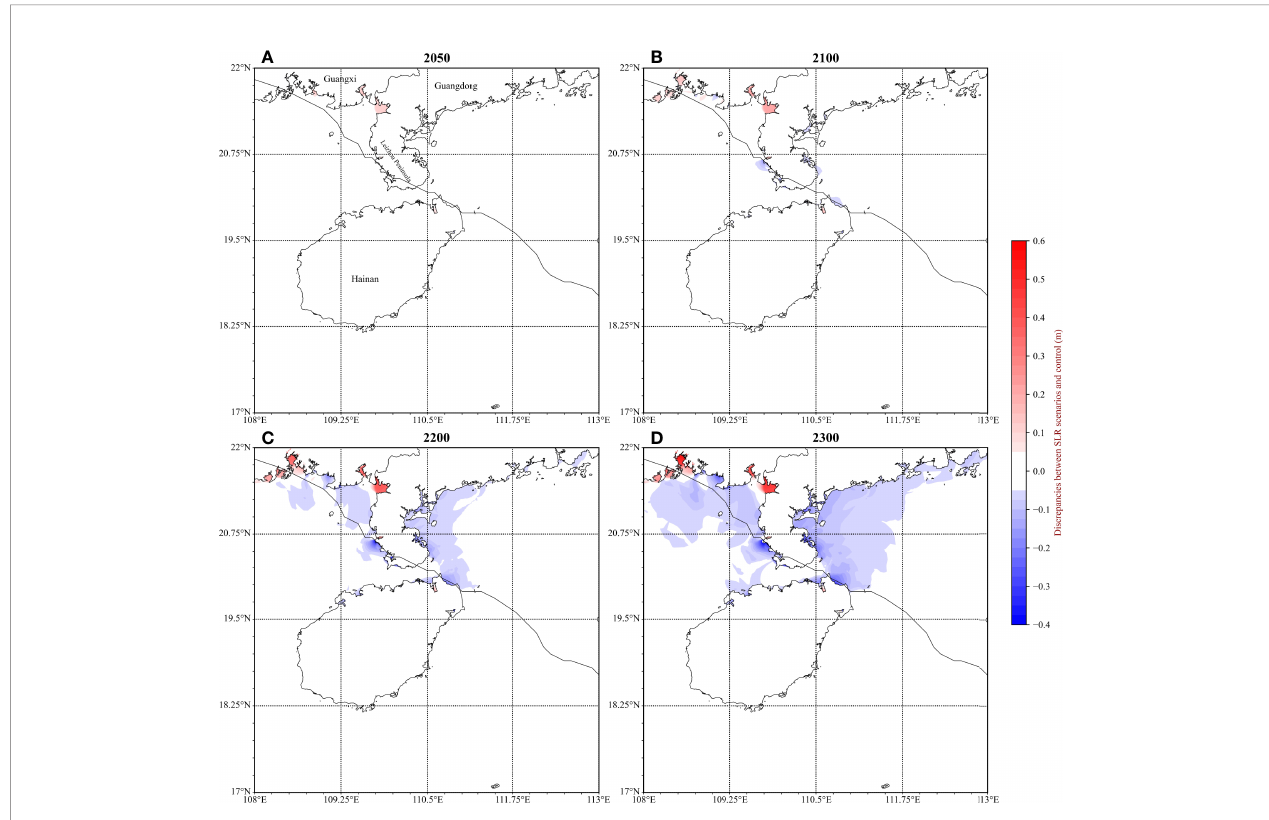
FIGURE 10 | Spatial distributions of peak surge difference (m) between the base case (Test 5) and SLR scenarios (Tests 10-13) in year (A) 2050, (B) 2100, (C) 2200, and (D)